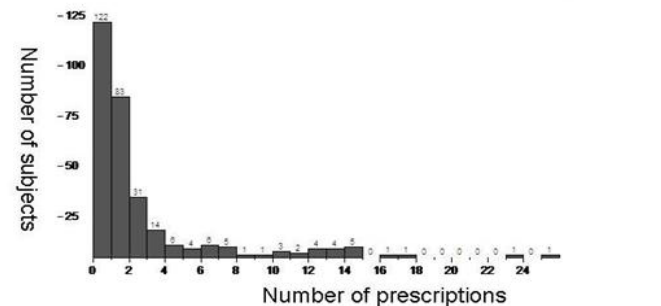
Figure. Number of subjects with corresponding number of prescriptions over the prior six months in a sample of patients (n=296) who were prescribed opioids and discharged from